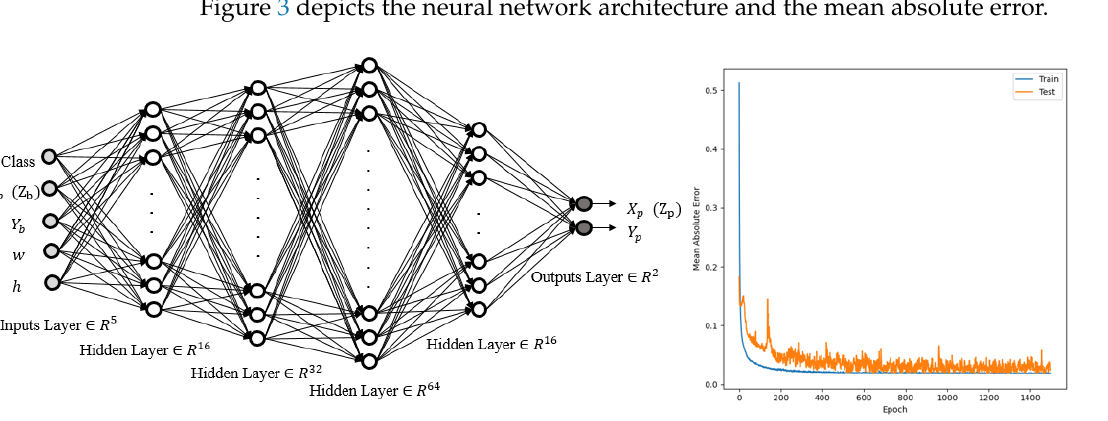
Figure 2. YOLO object detection in two views.